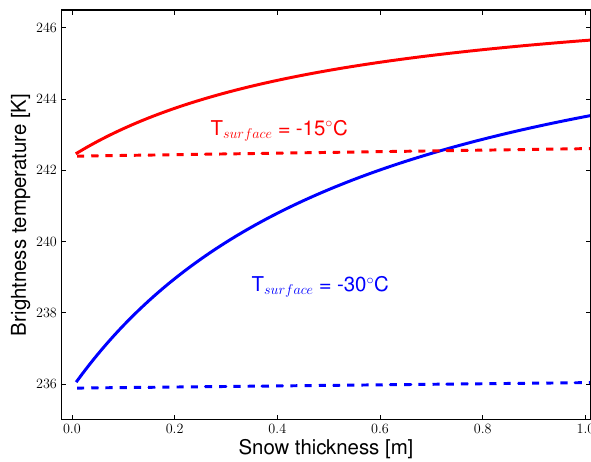
Fig. 2. Brightness temperature of 4m thick snow-covered ice as a function of snow thickness at horizontal polarisation at an incidence angle θ = 45 ◦ (solid line) for an ice surface temperature of − 30 ◦ C (blue) and of − 15 ◦ C (red). The dashed line indicates the brightness temperature of snow-covered ice, when the thermal insulation by snow is neglected.